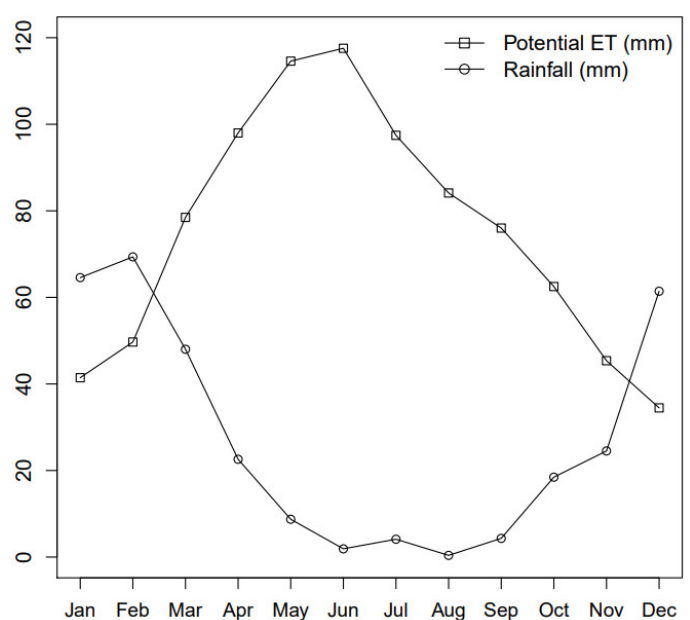
Figure 1. Mean monthly rainfall (P) and reference ET o from the California Irrigation Management Information System (CIMIS) station 19 in Castroville, CA.